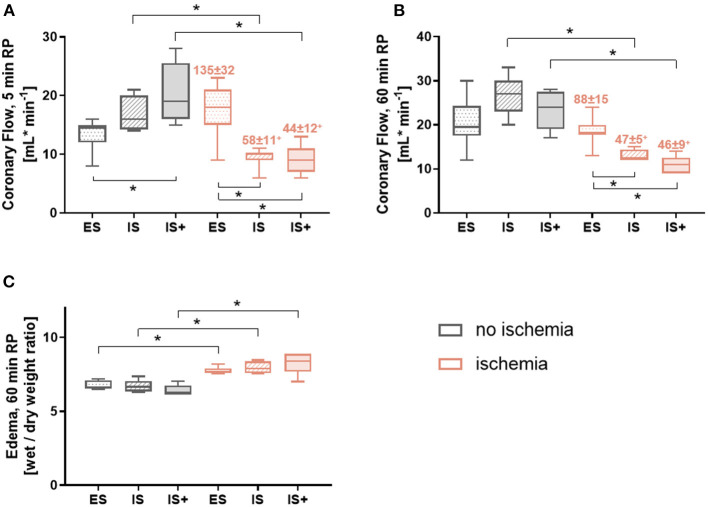
Vascular parameters. (A) Coronary flow at 5 min reperfusion (B) Coronary flow at 60 min reperfusion (C) Tissue water content at 60 min reperfusion. Data are expressed as median, 25–75 percentiles, and range; numbers indicate percentage of corresponding non-ischemic value. *p < 0.05, +p < 0.05 vs. ES. ES, ex-situ model; IS, in-situ model; IS+, in-situ model with cardioplegia; RP, reperfusion; n = 5–8 per group.